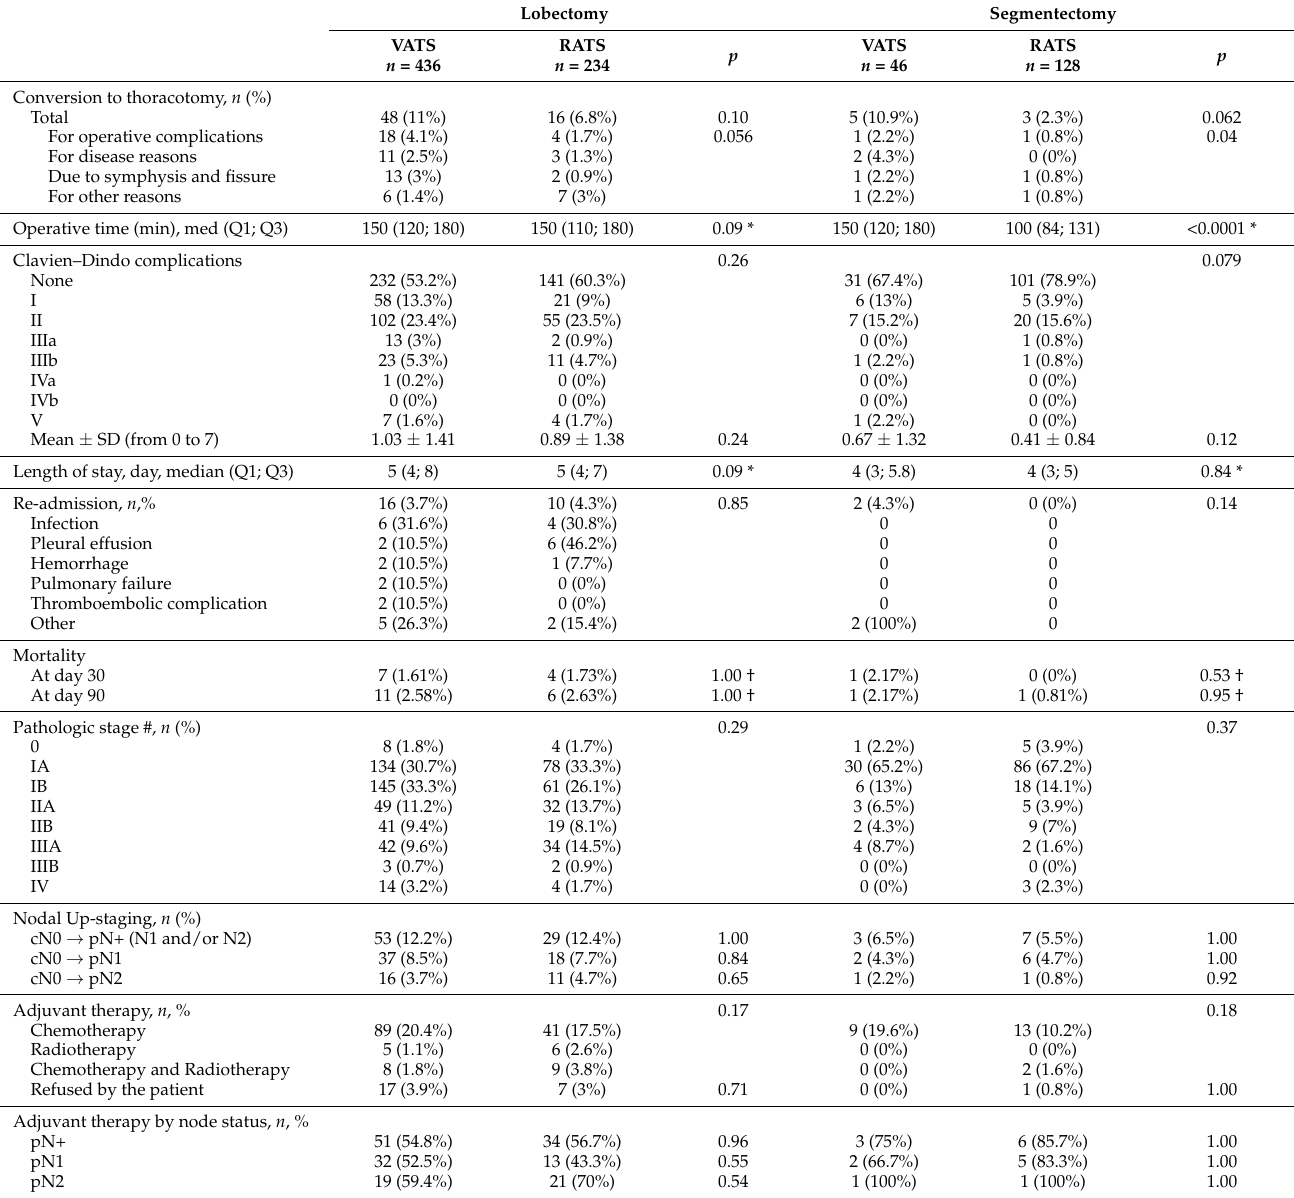
Table 3. Per-operative and post-operative characteristics of patients and tumors. Lobectomy